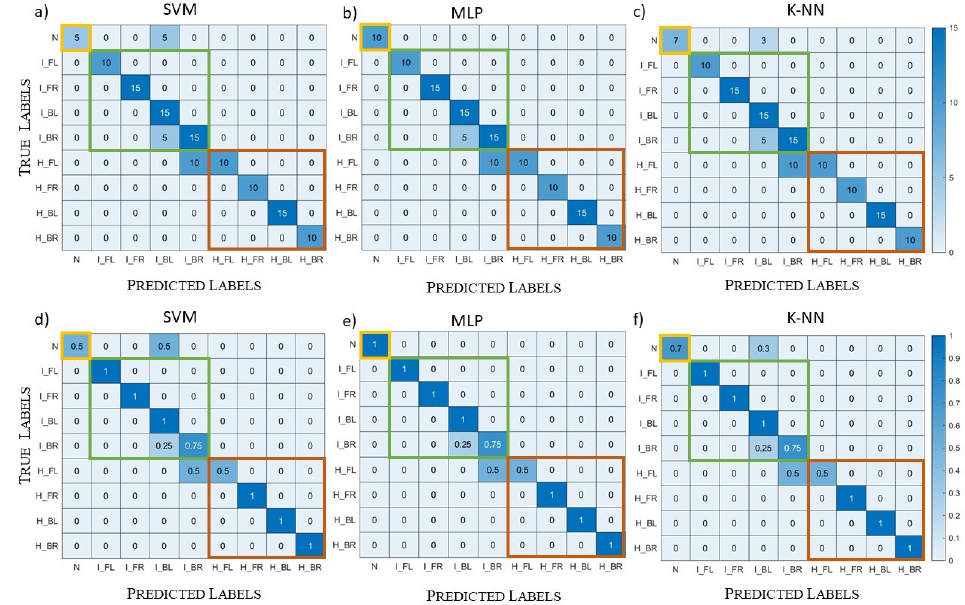
Figure 13. System B testing case, complex datasets: ( a – c ) confusion matrices; ( d – f ) normalized confusion matrices; ( a , d ) SVM results; ( b , e ): MLP results; ( c , f ) k-NN